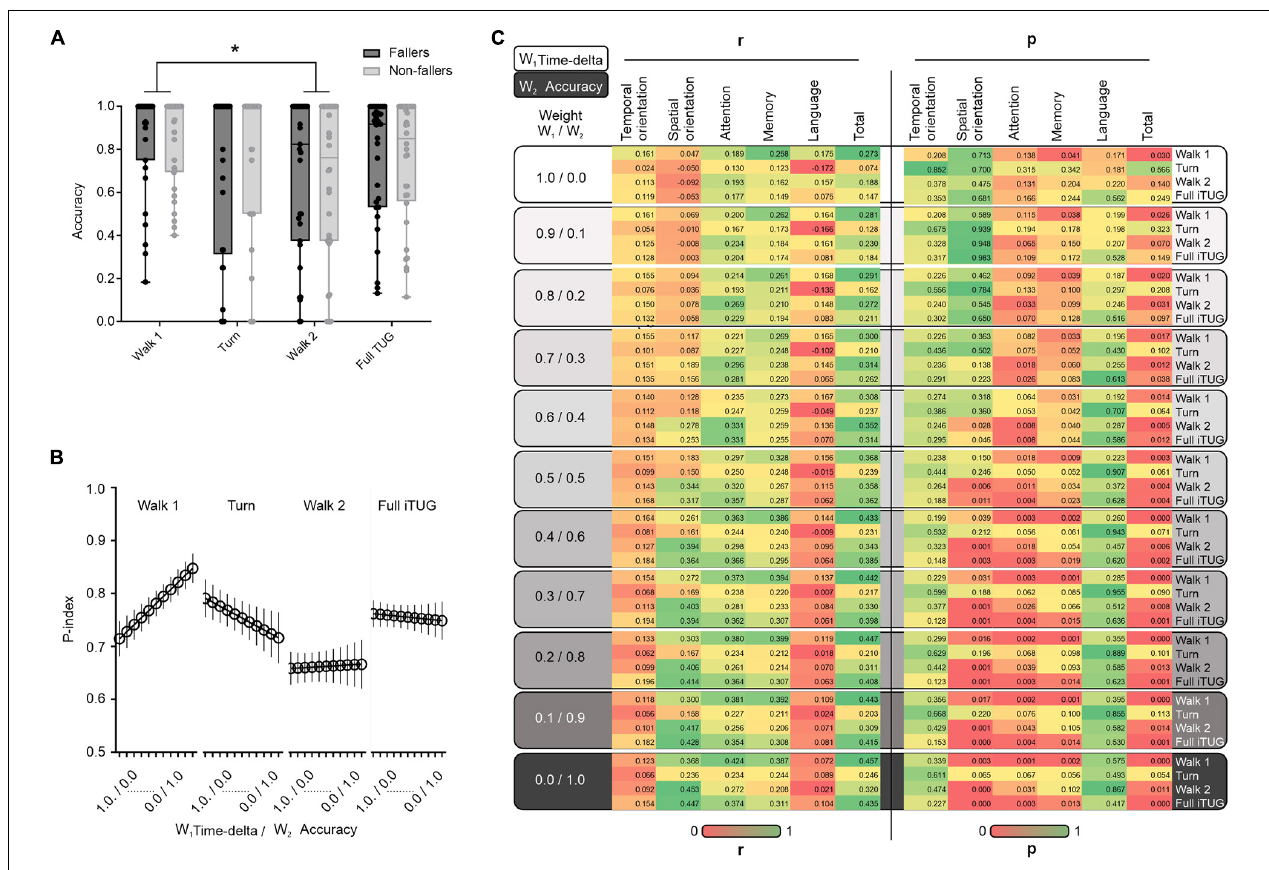
FIGURE 2 | The accuracy of the cognitive replies and DT performance in the iTUG test. (A) Between-group (fallers vs. non-fallers) comparison regarding the accuracy of the cognitive replies at different iTUG test phases. Note the difference in the accuracy of cognitive replies between the walk 1 and walk 2 phases. (B) The novel P-index is also substantially lower in the walk 2 phase. (C) Change in the coefficient of correlation between P-index and MMSE when the weight of the cognitive replies (accuracy; W 2 ) is changed by increasing W 2 and decreasing W 1 at 0, 0.1, 0.2, 0.3, 0.4, 0.5, 0.6, 0.7, 0.8, 0.9, and 1, respectively. Note the change in the correlation coefficients when the W 2 weight is increased. In (A) Box and whiskers plot showing accuracy of the cognitive replies in the different iTUG test phases (walk 1, turn, walk 2, and full iTUG). The central line is the median, the hinges of the plot are the 25th to 75th percentiles and extremes are min to max values. * p <